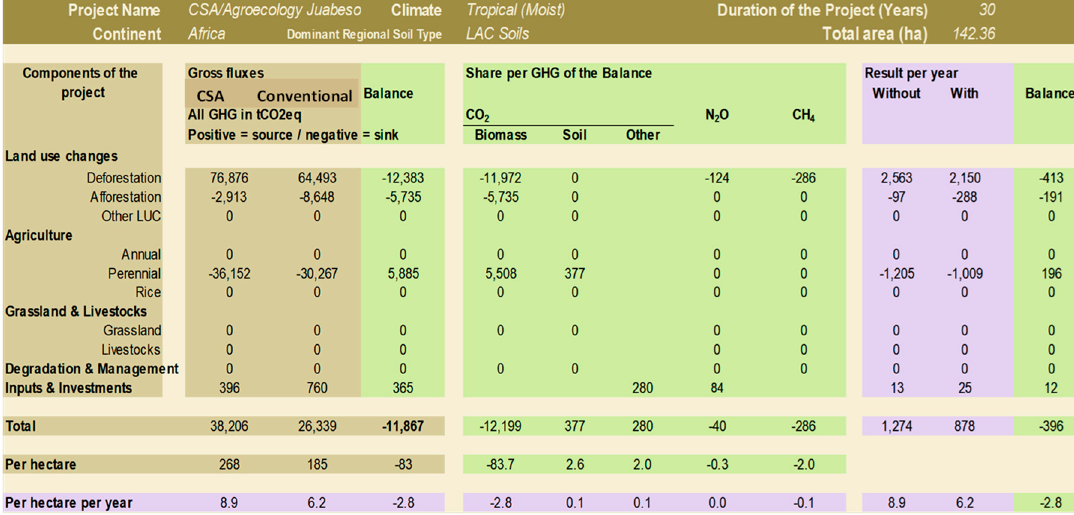
Figure 2. EX-ACT results showing fluxes per relevant component in cocoa farm projects in Juabeso Source: Field Data (2015).